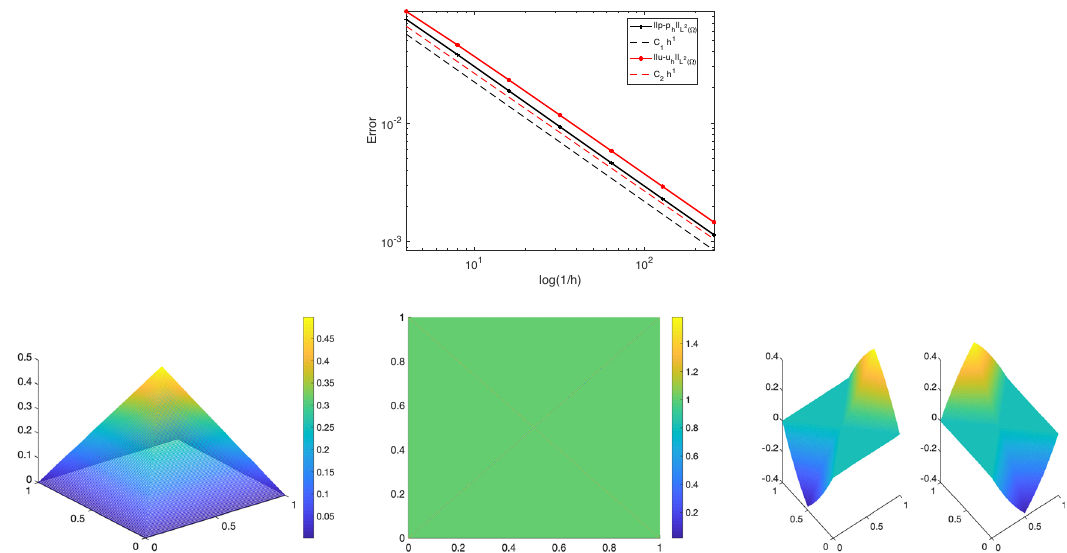
and the exact solution h ( right ) . Note h